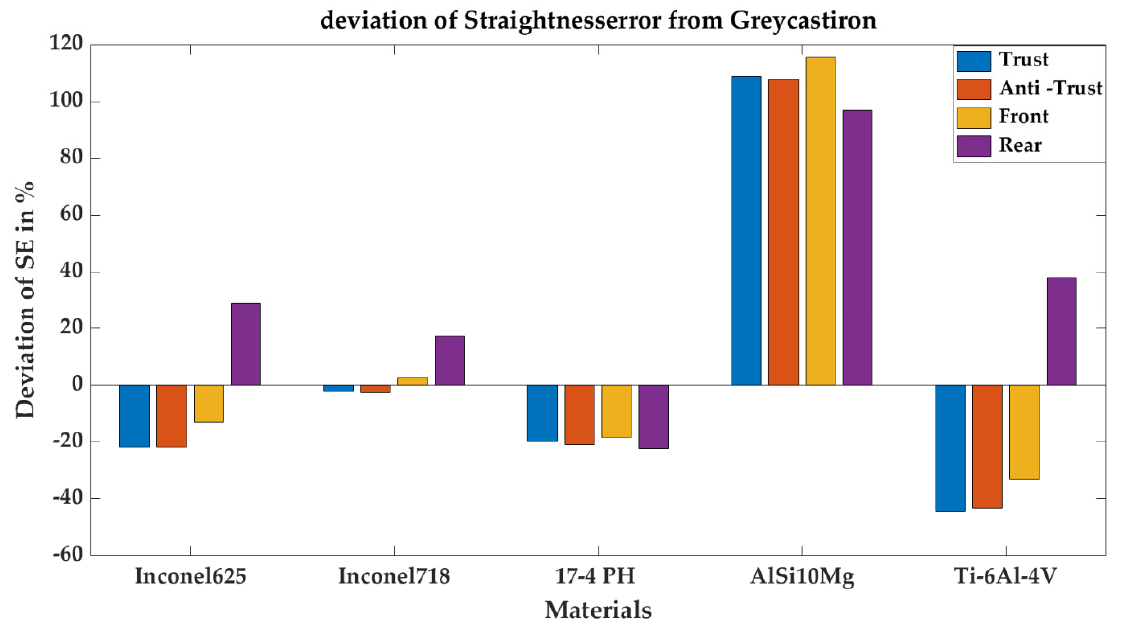
Figure 8. Deviation of straightness error of AM materials from grey cast